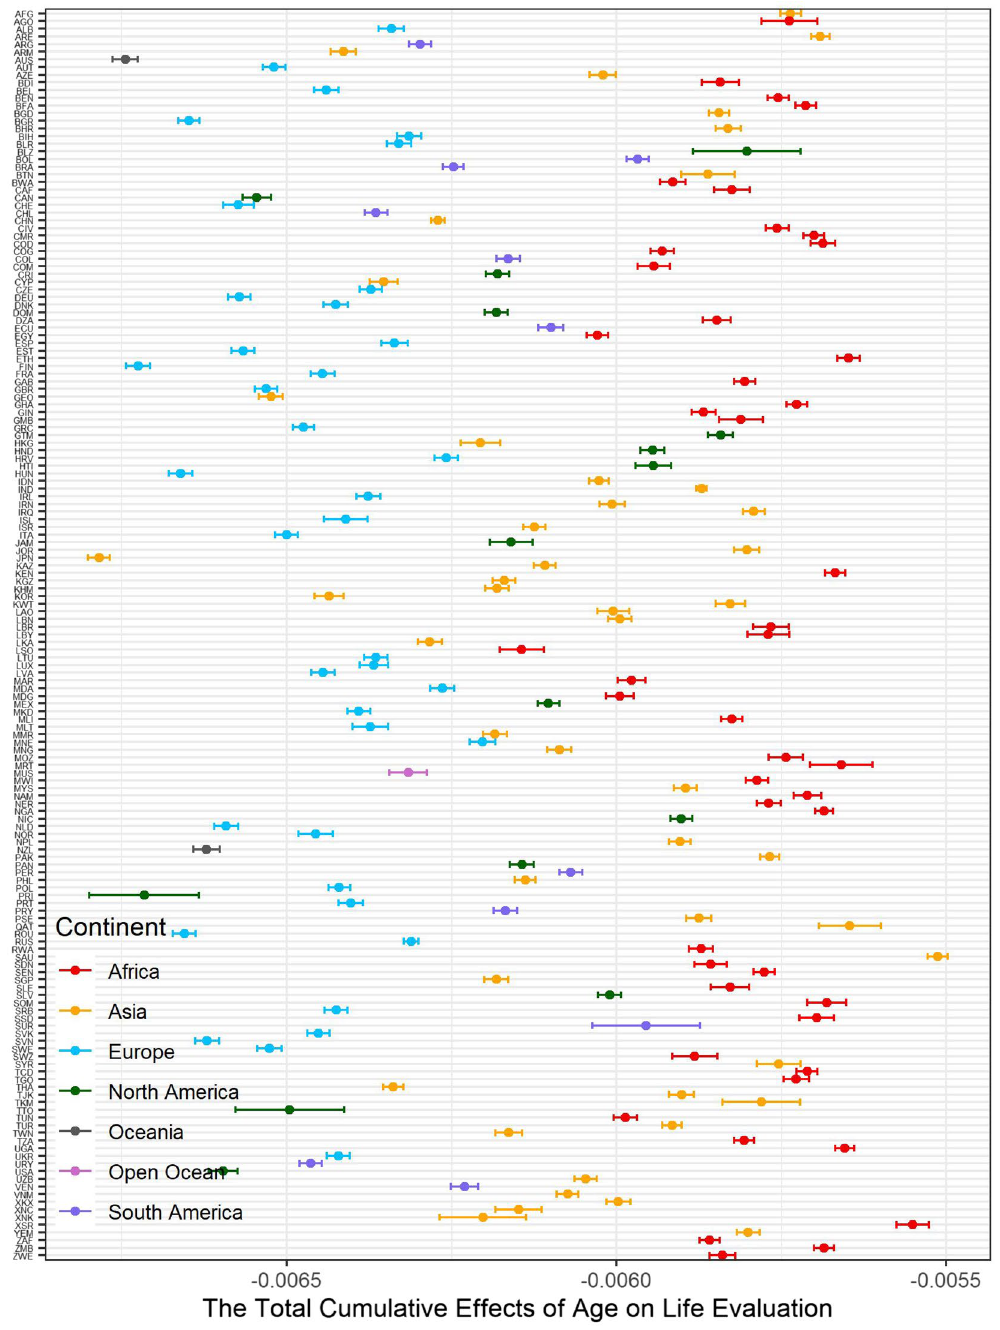
Figure 5. The summary of total cumulative effects of age on life evaluation by